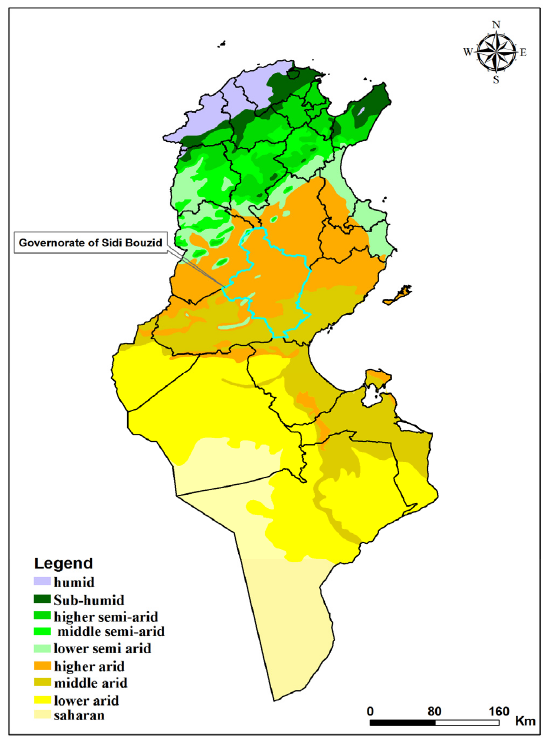
Figure 1. Bioclimatic map of Tunisia showing sand fly sampling sites in the governorate of Sidi Bouzid, Tunisia.